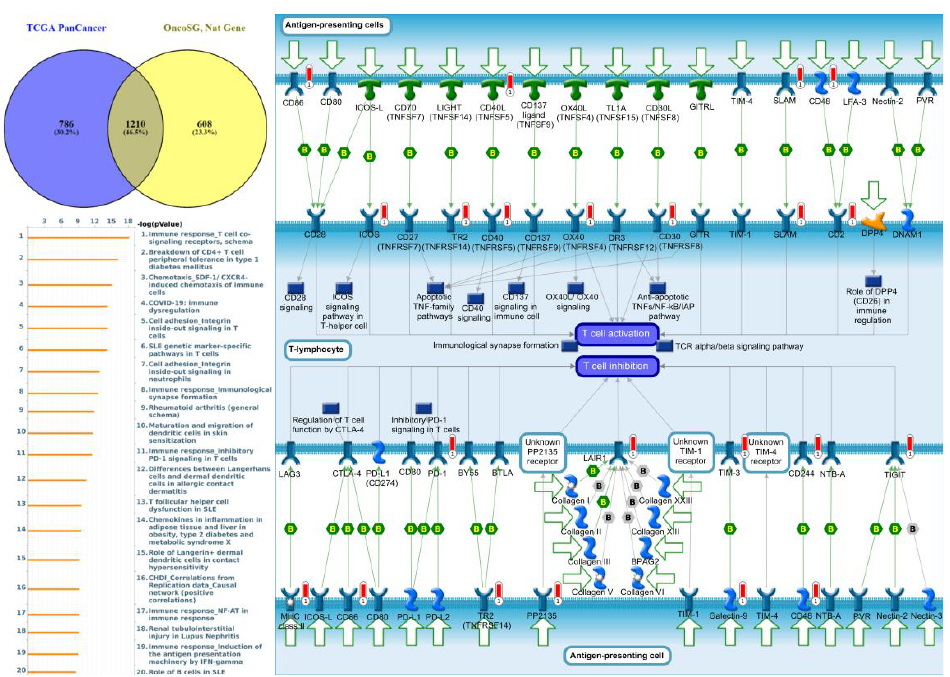
Figure 8. Expression of the protein tyrosine phosphatase non-receptor type 5 (PTPN5) signaling pathway in lung cancer (from Metacore). The functional analysis of “Development_Transcriptional regulation of megakaryopoiesis” was correlated with lung cancer development .